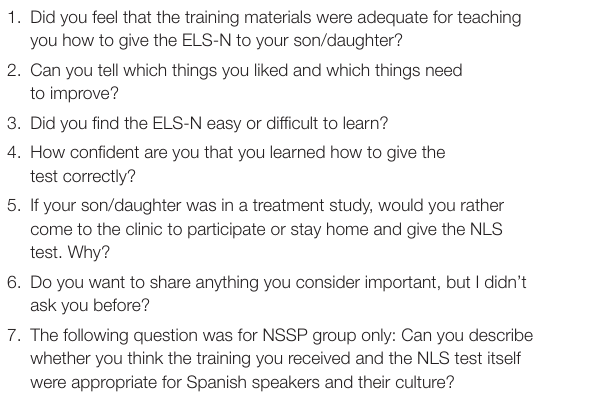
TABLE 2 | Exit interview questions for